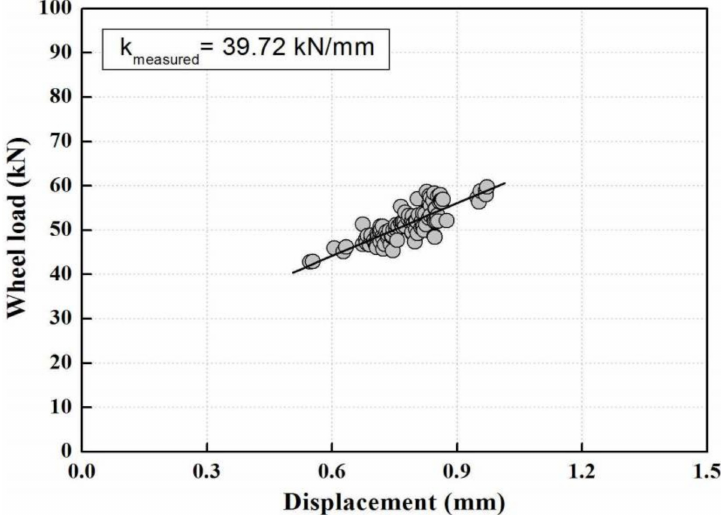
Figure 7. Measured track support sti ff ness by the conventional field